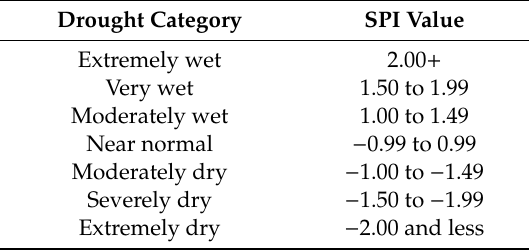
Table 2. Categories for standardized precipitation index (SPI) values [19,22]. Drought